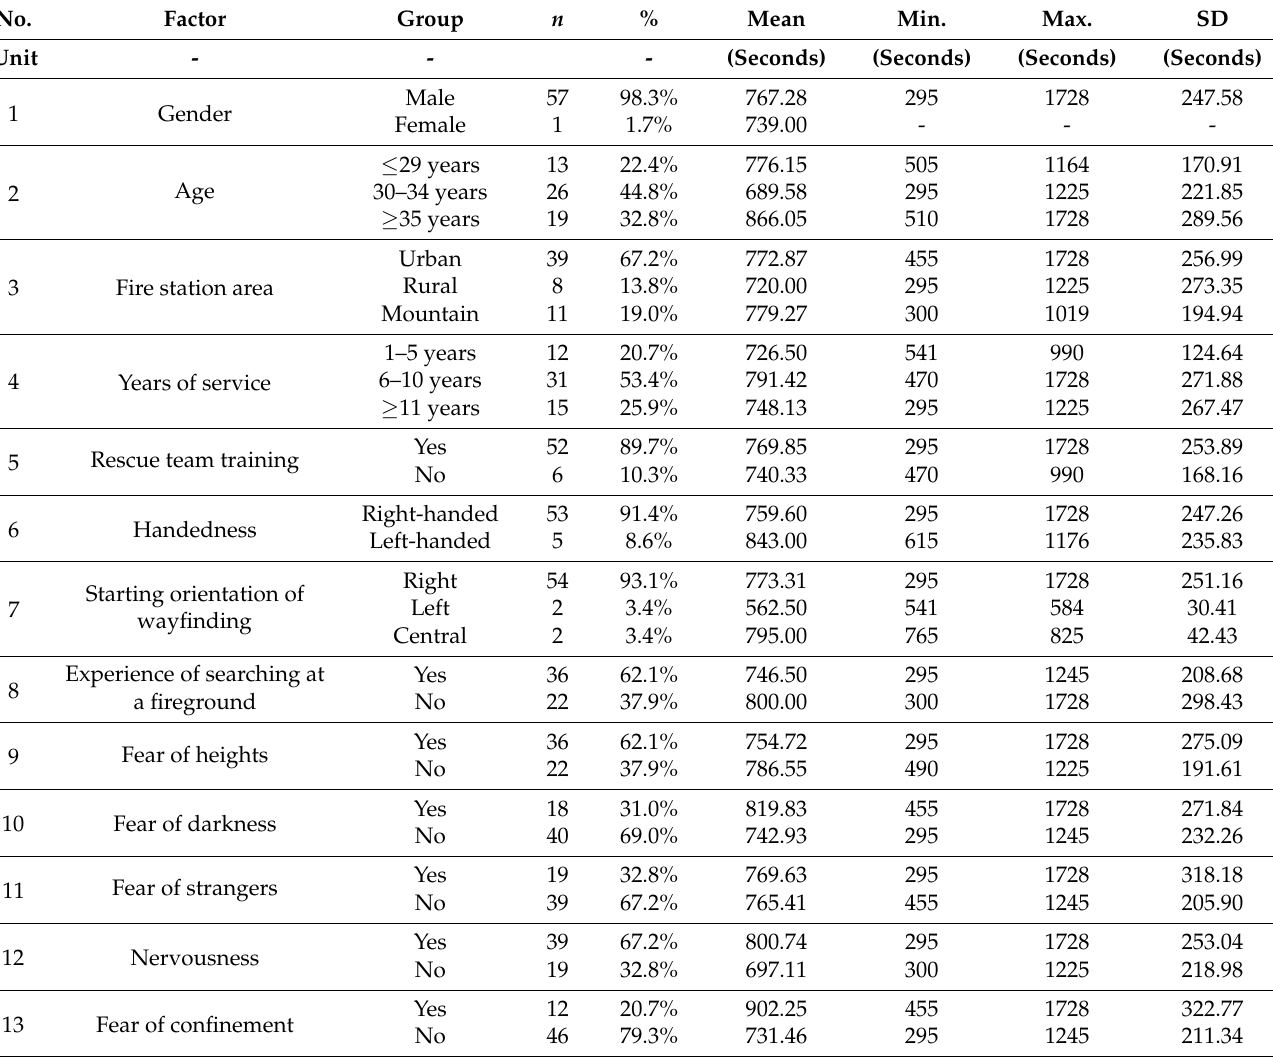
Table 1. Summary of descriptive